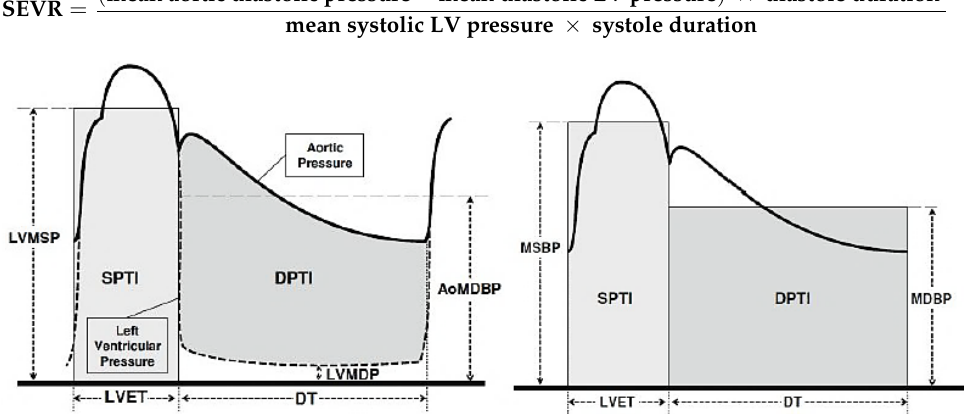
Figure 1. SEVR determinants (MSBP: mean blood pressure, SPTI: systolic pressure time index, DPTI: diastolic pressure time index, LVET: LV ejection duration, LVMDP: mean diastolic pressure in LV, LVMSP: mean systolic pressure in LV, DT: diastole duration) (adapted after